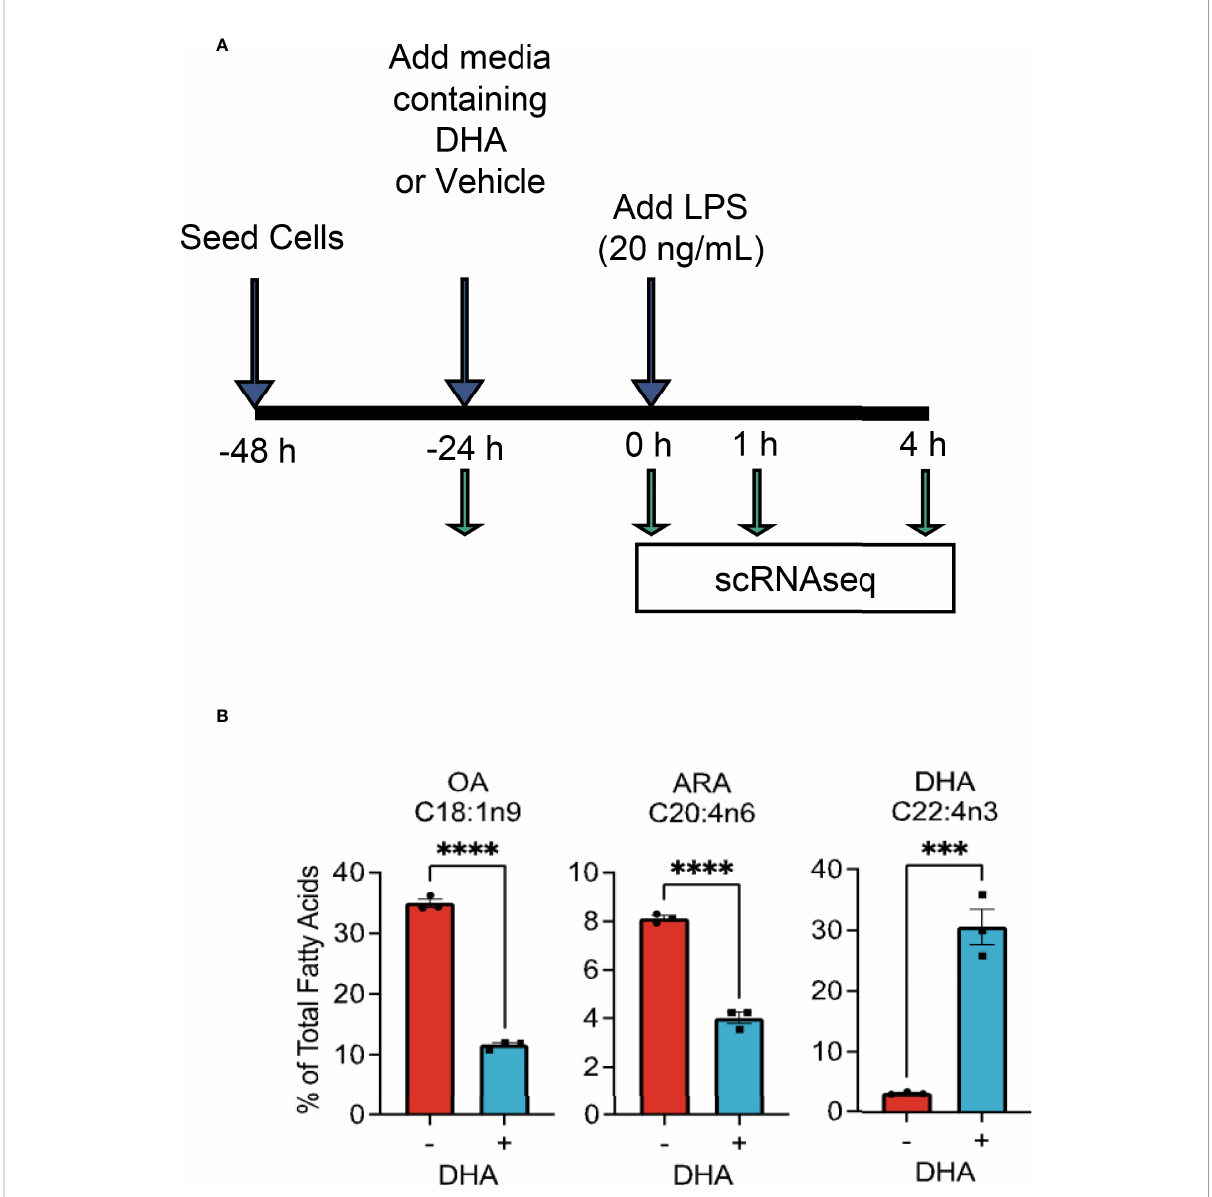
FIGURE 1 Experimental design for scRNAseq and DHA incorporation into FLMs. (A) FLMs were seeded in 6 well plates at -48 h in mRPMI medium containing 10% FBS. At -24h, medium was replaced with mRPMI containing 0.25% FBS with either DHA or Veh. At time 0 h (24h after DHA supplementation), cells were treated with 20 ng/mL LPS. Sample start times were staggered to allow collection of all samples simultaneously, after the indicated treatment times. (B) DHA supplementation results in increased DHA levels in the phospholipid membrane at the expense